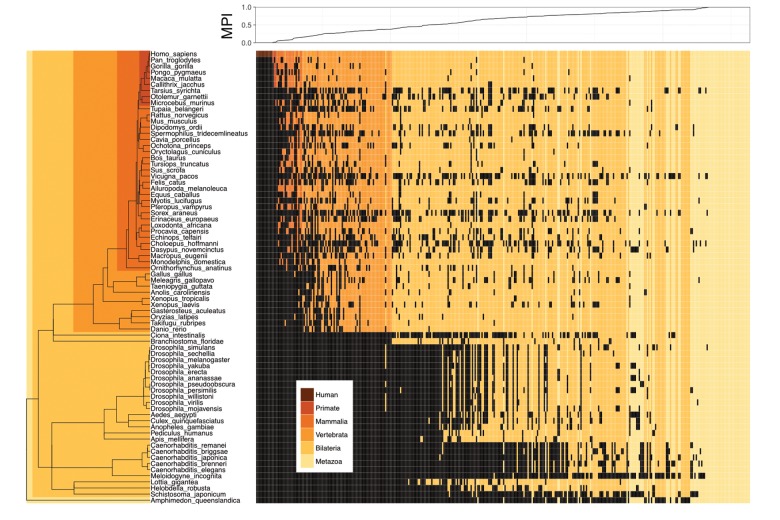
Motif prevalence index (MPI) of TF binding specificities in humans. Phylogenetic relationship between 364 human TF binding specificities (motifs) from the JASPAR database and their MPI scores (upper panel). Color codes denote the presence of motifs in various metazoan lineages. Black denotes the absence of motifs.